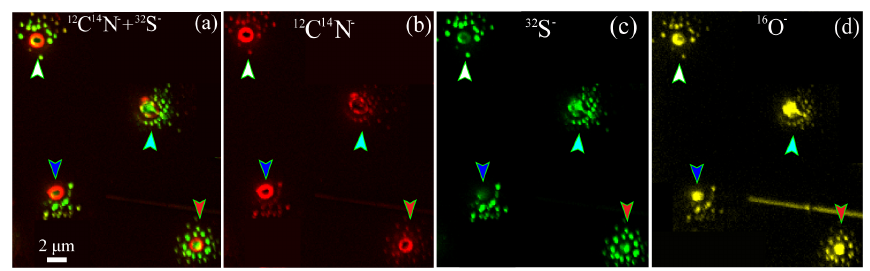
Figure 6. NanoSIMS intensity threshold maps of individual aerosol particles surrounded by satellite particles: (a) overlay of 12 C 14 N − and 32 S − ion maps of individual particles, (b) CN − , (c) S − , and (d) O − maps. Four particles were indicated by white, pink, blue, and red